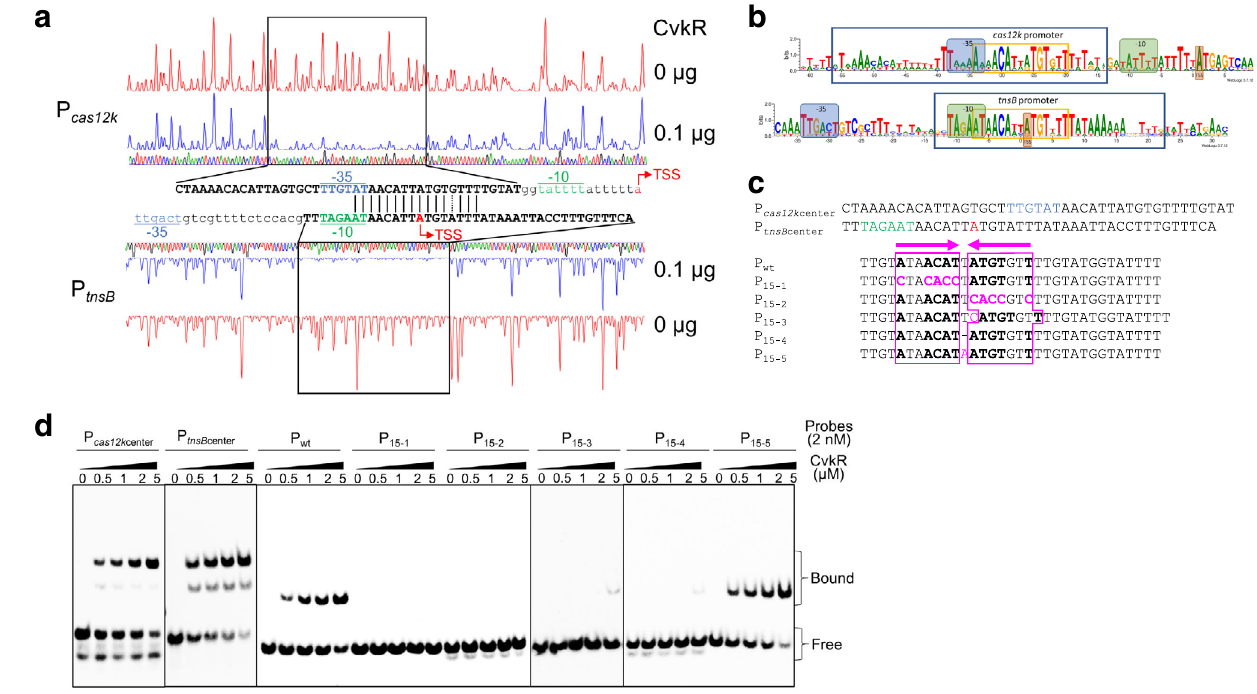
Fig.6|AnalysisofCvkRbindingmotifs.a DNaseIfootprintingoftheFAM-labeled P cas12k and P tnsB promoter sequences in the absence (red graphs) and presence of 0.1 µ g CvkR (blue graphs). The protected region is boxed. Dideoxynucleotide sequencing traces are displayed (green, A; blue, C; black, G; red, T) and the DNA sequences protected by CvkR are indicated below (for P cas12k ) or above (for P tnsB ) the corresponding regions in capitalized bold letters. The sequence overlap is markedbyverticalblacklines.Adashedlineindicatesasingledifferentnucleotide. The area adjacent to the CvkR-protected regions is displayed in lowercase letters. The TSS (red), − 10 (green) and − 35 elements (blue) are highlighted. b Sequence logooftheCvkRmotifbasedonsequencealignmentsof cas12k and tnsB promoters of 15 CAST systems with cvkR genes (for sequence details see Supplementary Fig.6).Inthesequencelogos,the − 35and − 10promoterregionsareshadedinblue